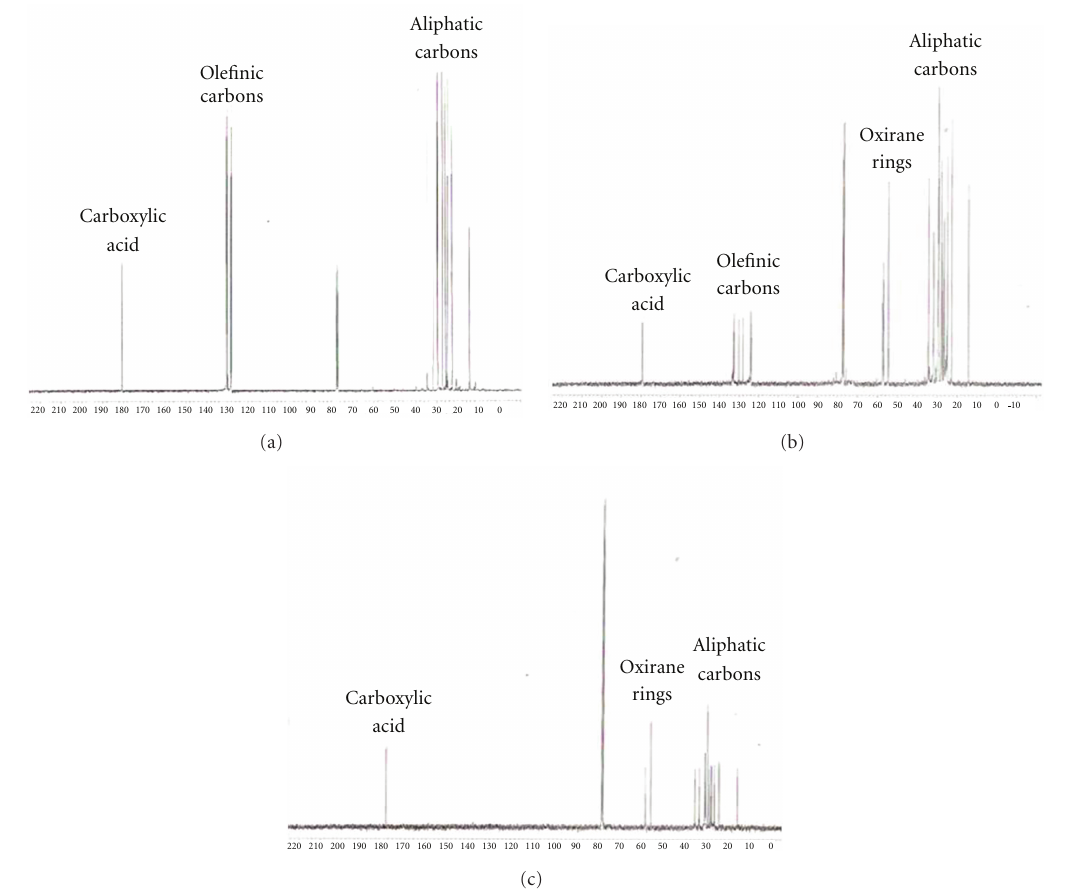
Figure 7: 13 C NMR spectrum of LA (a), MEOA, (b) and diepoxide LA